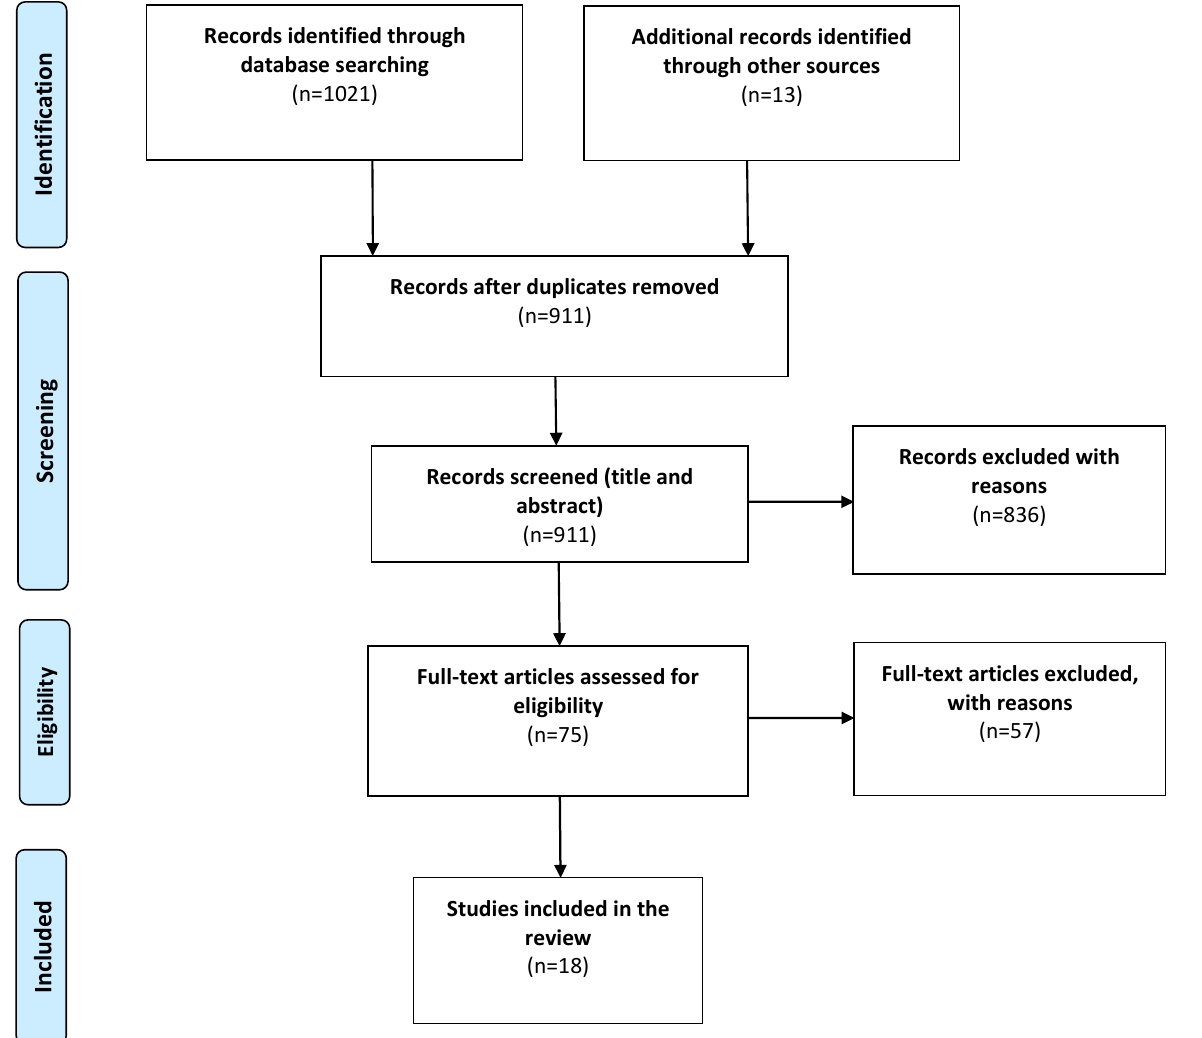
Figure 1. Preferred reporting items for systematic reviews and meta-analyses (PRISMA) flow chart detailing the stages of study retrieval and selection [38].